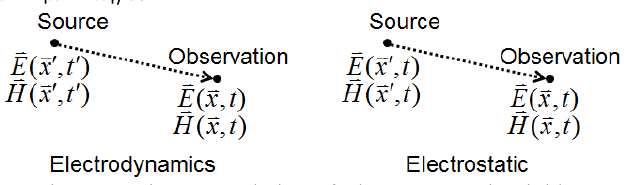
Figure 1: Time Retardation of Electromagnetic Fields For Electrostatic fields where the source does not change over time: ⃑(⃑  ,) = ⃑(⃑  ,′) and ⃑(⃑  ,) = ⃑(⃑  ,′) ; therefore,